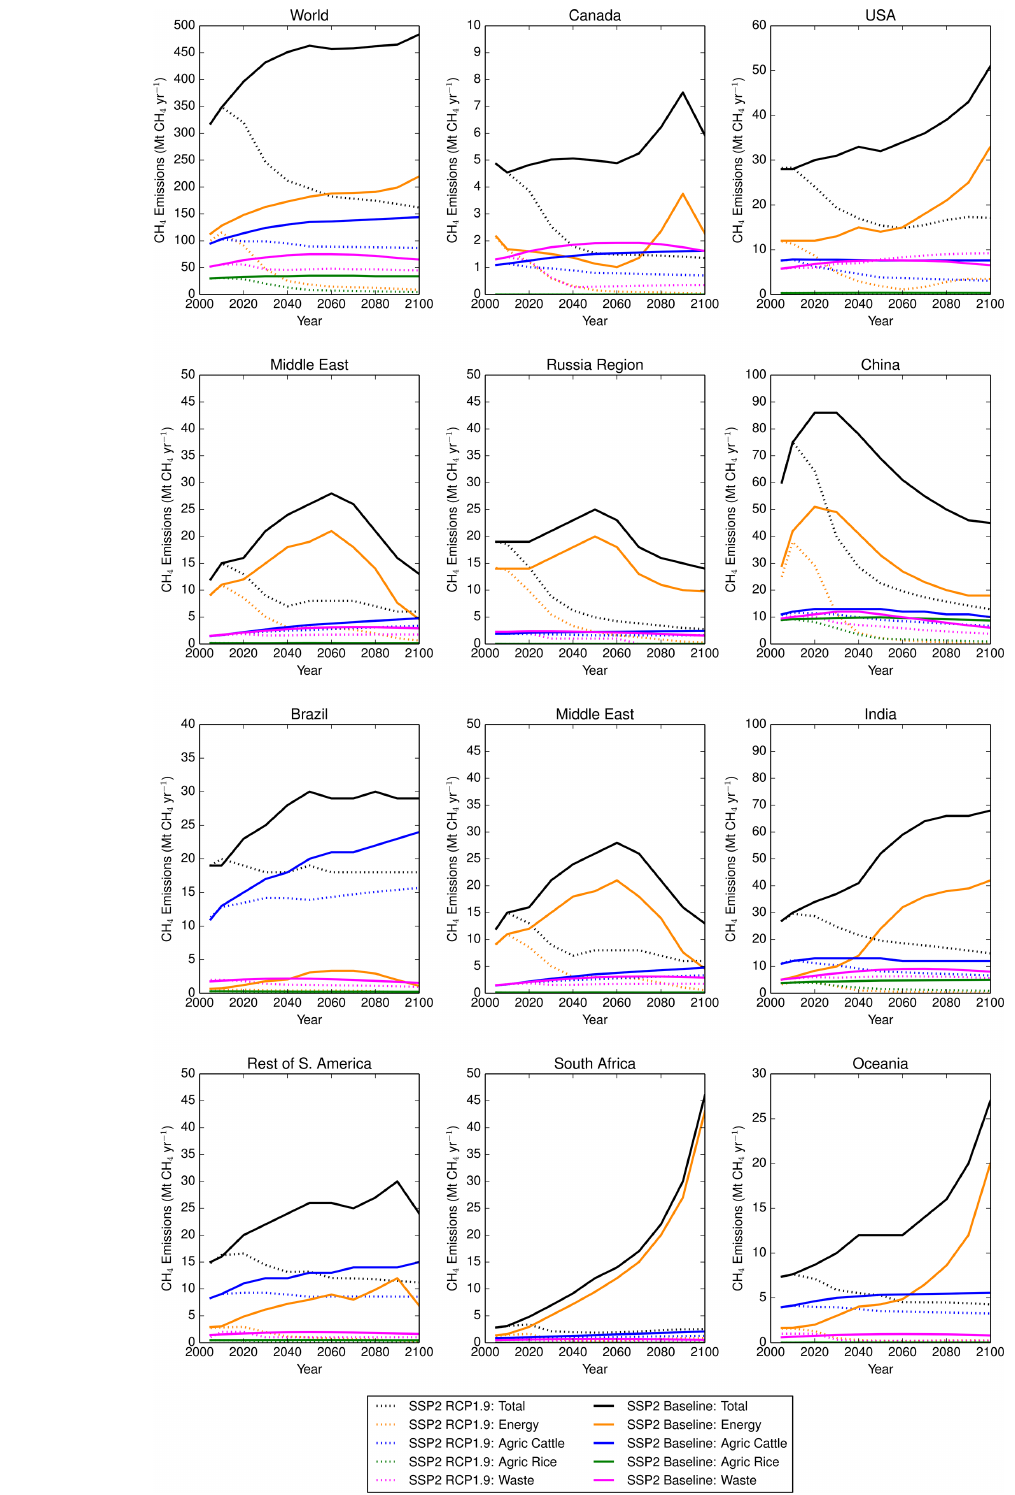
Figure 4. Time series of annual methane emissions between 2005 and 2100 from all and selected anthropogenic sources according to the IMAGE SSP2 Baseline (solid lines) and SSP2-RCP1.9 (dotted lines) scenarios, globally and for selected IMAGE regions, with total emissions in black, energy sector in red, agriculture – cattle in blue, agriculture – rice in green, and waste in magenta. Note that the y axes have different scales for